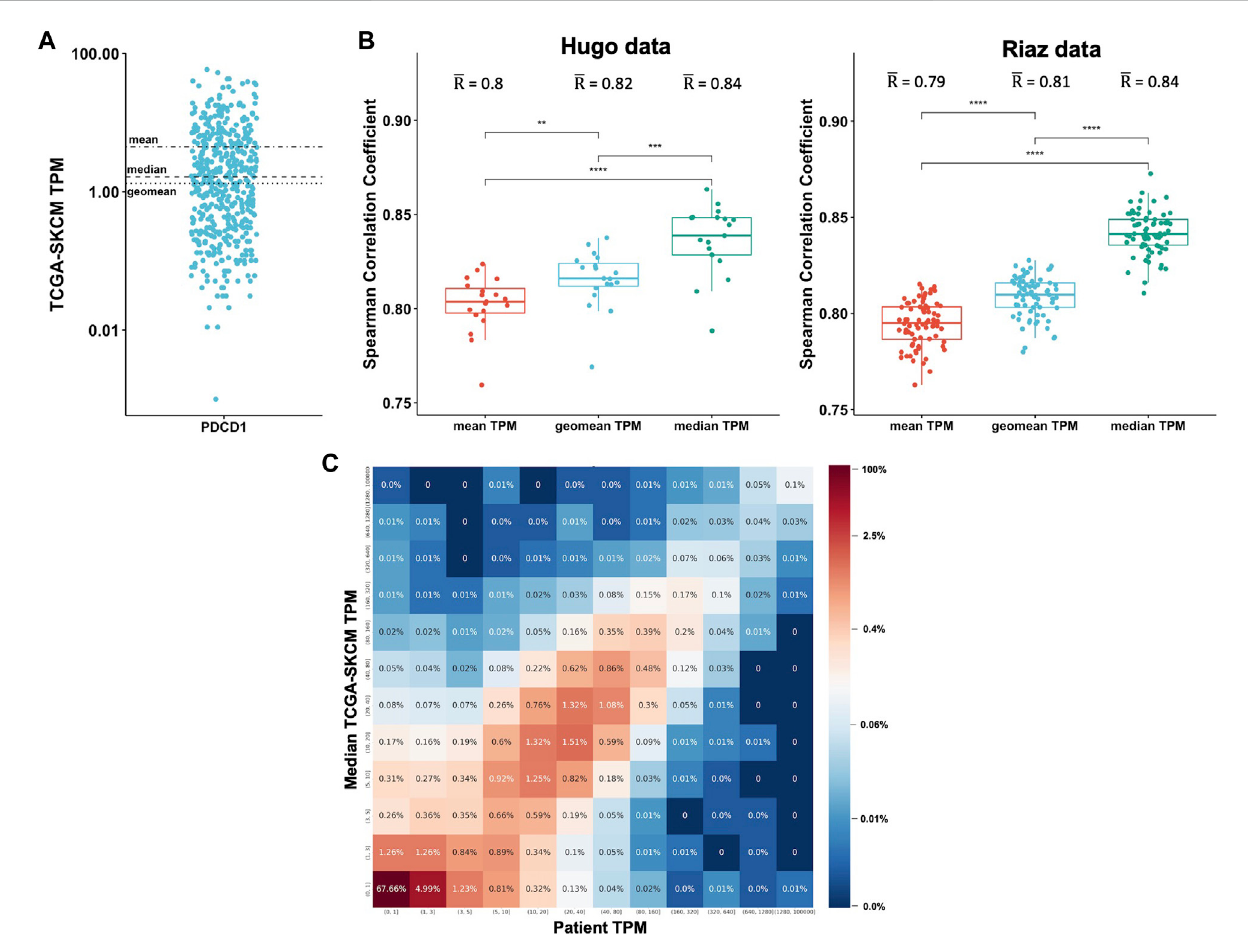
FIGURE 2 Expression data from TCGA correlates well with patient-speci fi c RNA-Seq data. (A) . The mean, median, and geomean TPM were calculated for the gene PDCD1 for the 470 TCGA-SKCM patients (each dot represents one patient). (B) . For each patient in the Hugo (Hugo et al., 2016) and Riaz (Riaz et al., 2017) datasets, all genes were considered and TPM values were correlated to the TCGA-SKCM mean, median, and geomean TPM. Spearman correlations coef fi cientswerecalculated. (C) .Foreachpatient,theTPMvalueswereseparatedintorangesforboththepatient-speci fi c( x -axis)andtheTCGAmedian ( y -axis) TPM values. For each TPM range combination, the fraction of genes expressed within the corresponding TPM ranges is shown as a percentage and is also